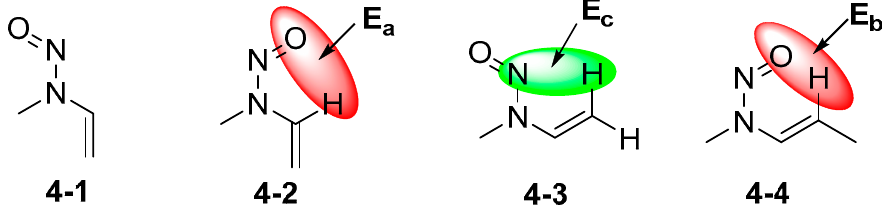
gen bond between the oxygen or nitrogen in the nitryl moiety and the hydrogen in urea, restricting its configurational exchange. The presence of hydrogen bonds was established by energy calculations at the M062X/Def2TZVP level of theory. Both the E configuration ( 8a ) and the Z configuration ( 8b ) might form a hydrogen bond. The E configuration ( 8a ) was predicted to be 4.97 Kcal/mol lower in energy than the Z configuration ( 8b ), indicat- ing that the E configuration ( 8a ) may be the stable configuration, with an intermolecular hydrogen bond of approximately 2.225 Å (Figure 5A). The DFT quantum chemical calcu- lations showed that the calculated 13 C NMR data for the E configuration ( 8a ) were less different from the experimental data. Based on the above evidence, one set of NMR signals was concluded to be from the E configuration ( 8a ). Figure 5. The possible conformers ( A ), their energy values ( A ) and the calculated 13 C-NMR data ( B ) for N-nitrosamines of 8. A summary of these calculated NMR data and their comparisons with experimental values are presented in Tables 3 and 4, and the correlation coefficients are presented in Table 5; these data were used to assign the NMR signals for the Z and E configurations of N-nitrososarcosine 3 – 7 . Table 6 shows the Gibbs free energy values (G, Kcal/mol) of Z / E isomers for compounds 3 – 7 at the M062X/Def2TZVP level of theory with Grimme’s D3 correction. The major calculated molecular models of 3 – 7 are shown in Figure 6.